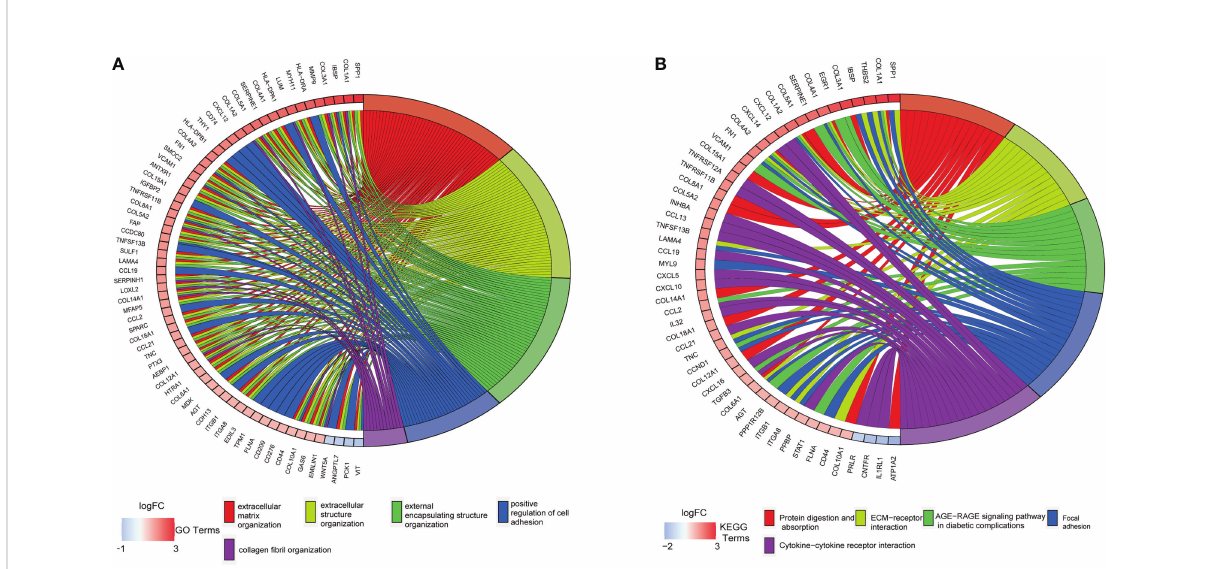
FIGURE 3 Enrichment analysis of GSE51472 and GSE153555 datasets. (A) Gene Ontology (GO) enrichment. (B) Kyoto Encyclopedia of Genes and Genomes enrichment